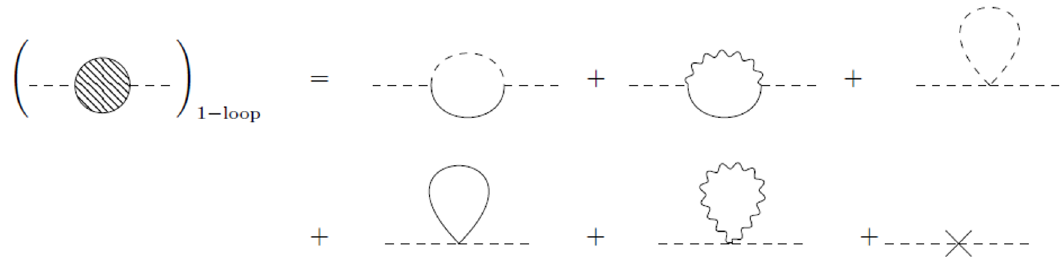
Figure 4 . Feynman diagrams contributing to the two-point Green’s function of the Goldstone field ρ . Curly lines refer to the gauge field, solid ones to the Higgs field and dashed ones to the Goldstone